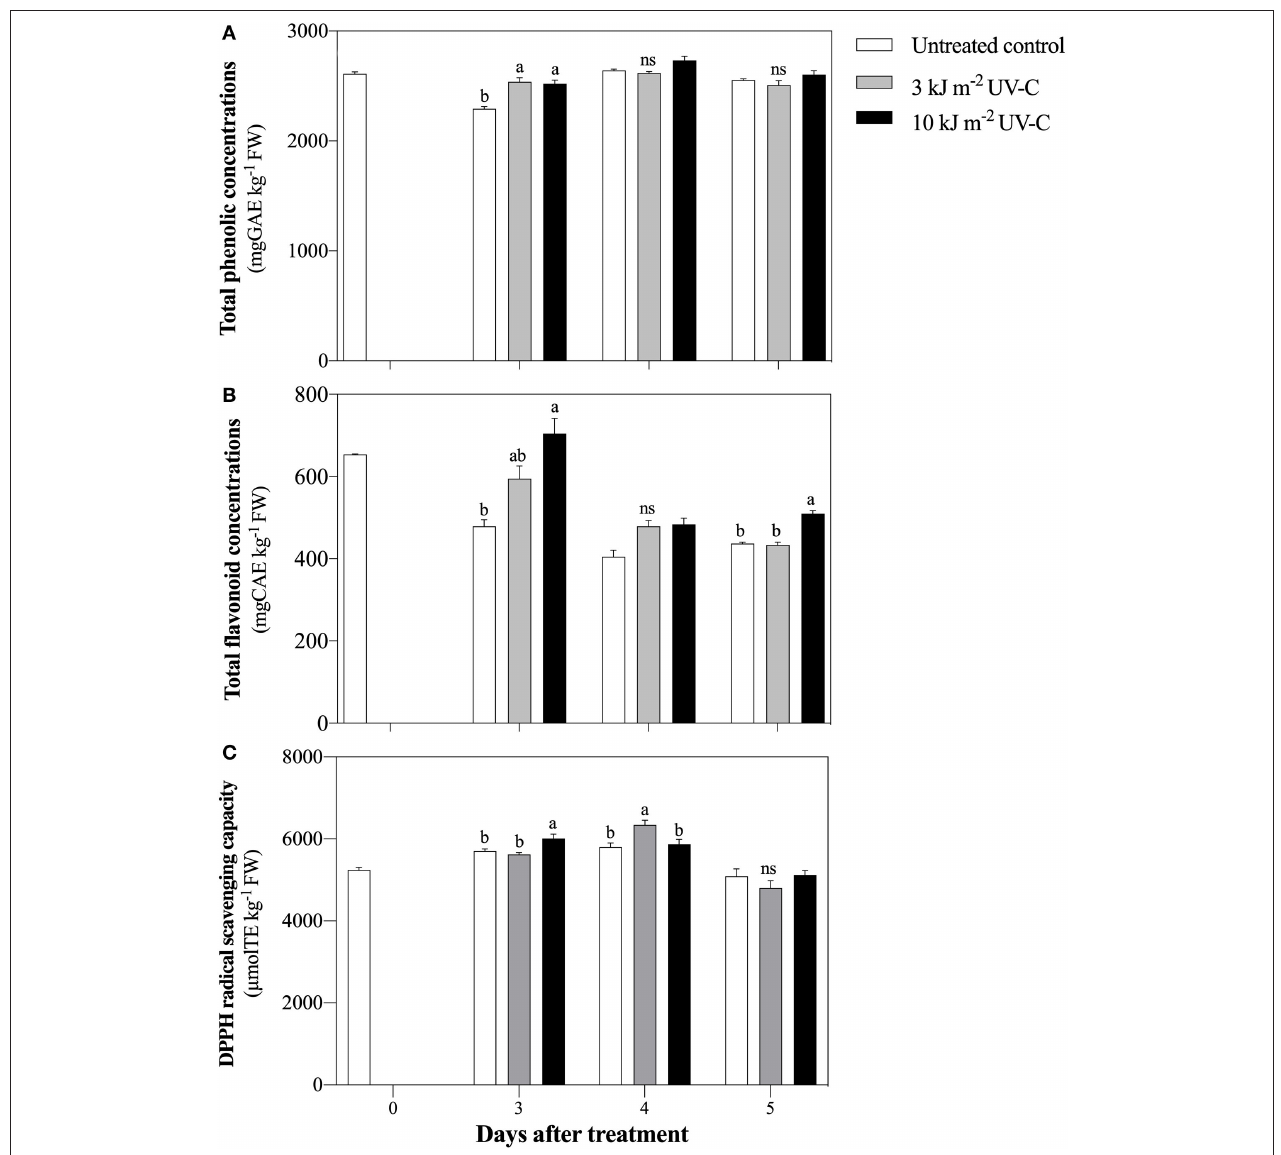
FIGURE 5 | Effect of UV-C treatment on change of total phenolic concentrations (A) , total flavonoids concentrations (B) , and DPPH radical scavenging capacity (C) in satsuma mandarin fruit in untreated control, 3 kJ m − 2 UV-C, and 10 kJ m − 2 UV-C groups. The different letters indicate significant differences at P ≤ 0.05 by LSD test at each day with the mean ± SE of three